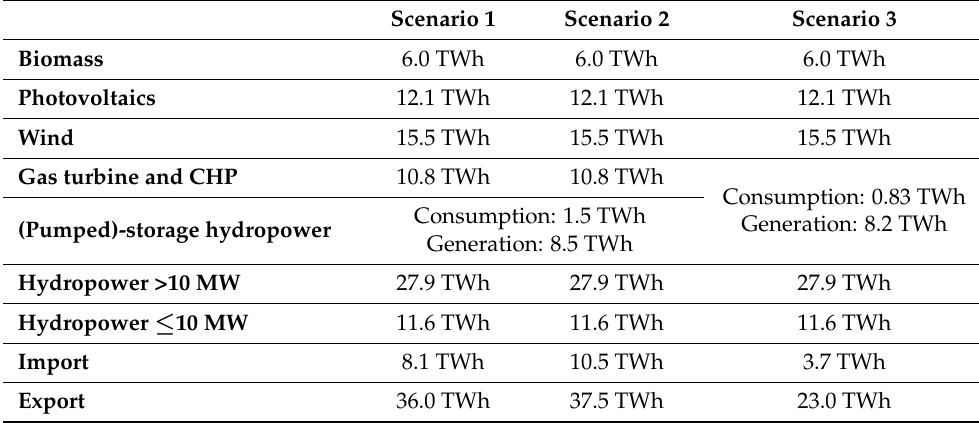
Table 6. Comparison of power generation for each